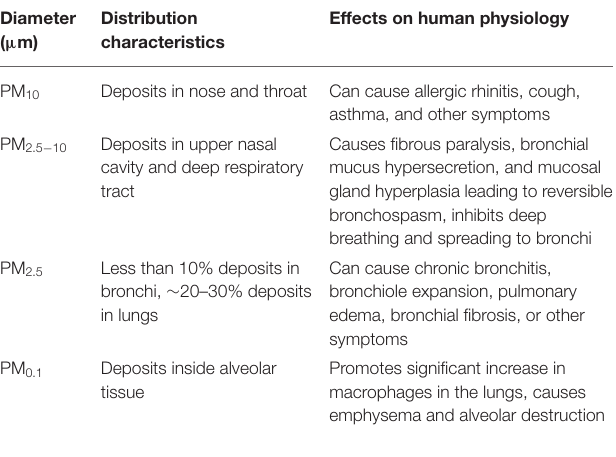
TABLE 1 | Effects of PM on the human respiratory system.